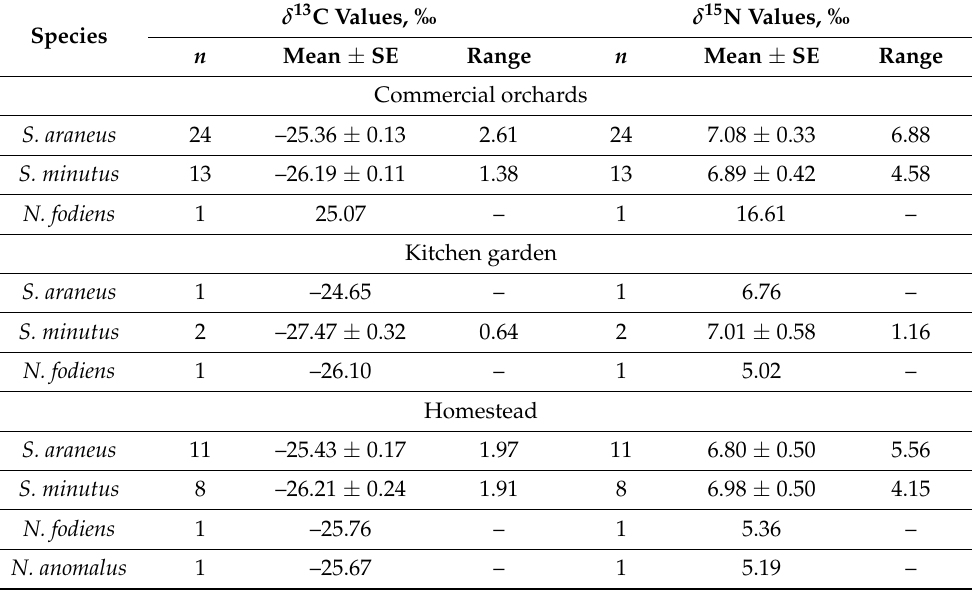
Table 2. Central positions and ranges of stable isotope ratios in the hair of small mammals from commensal habitats,